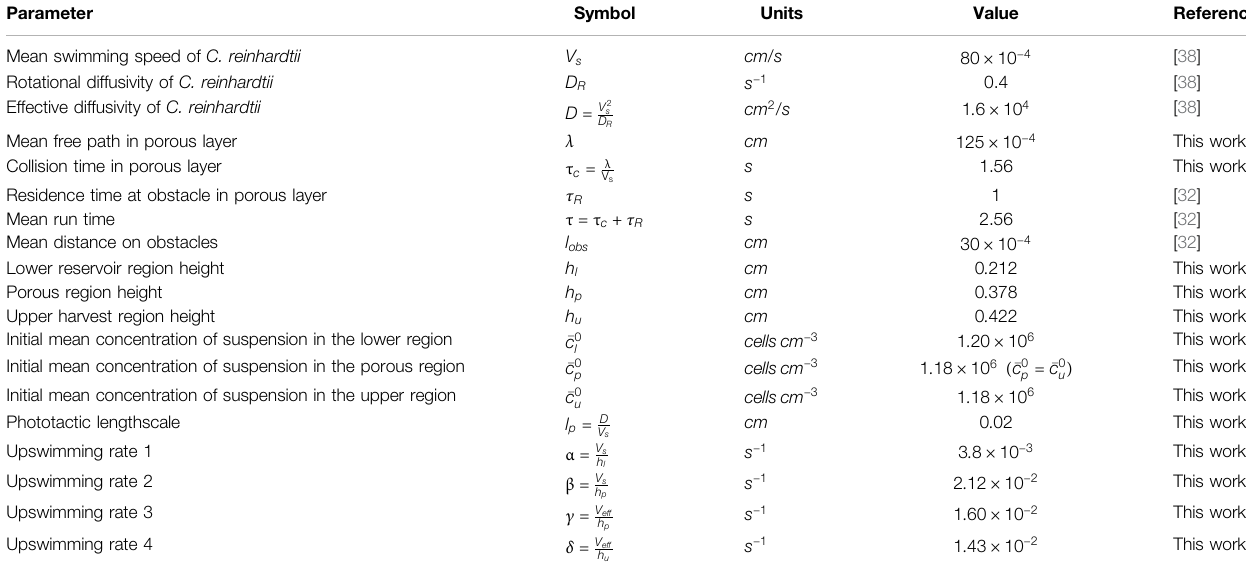
TABLE 1 | Essential model parameters for the mesh + beads case. Values were obtained from direct measurements of our experimental system or literature values for the swimming parameter of C. reinhardtii grown under identical conditions. Parameter